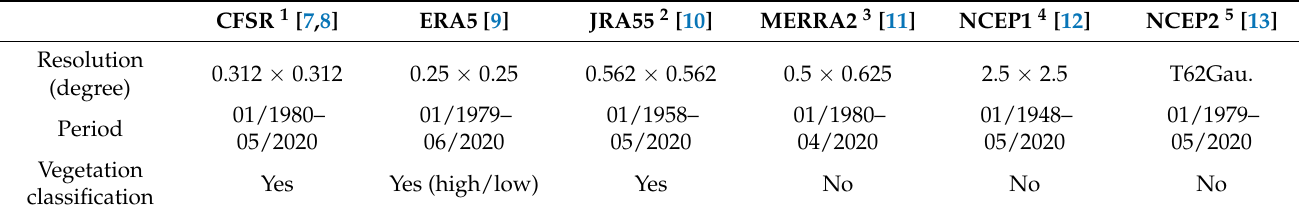
Table 1. Reanalysis databases considered in this